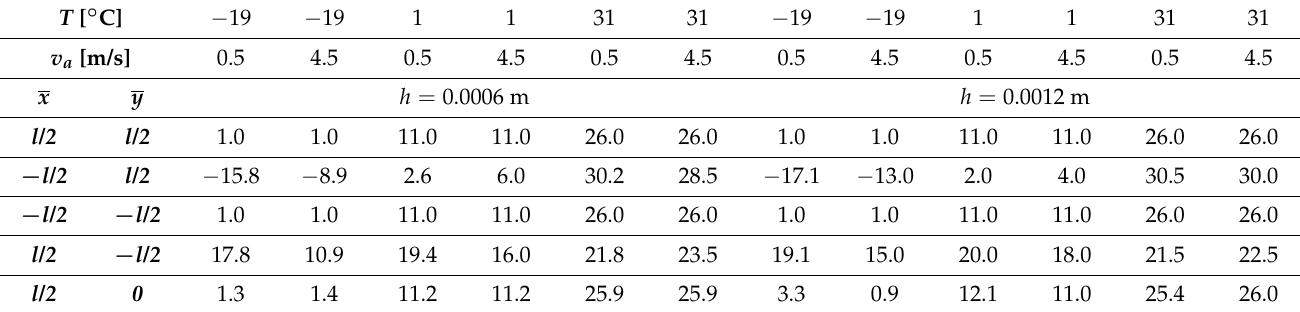
It is worth noting how the cross-flow heat exchanger behaves when the plate is twice as thin as the one adopted for this article. An aluminium plate was used for the tests. The presented research shows that the thinner the plate, the less the supply air heats up, although the differences are small. The differences in the final air temperatures are a bit closer to 21 ◦ C (room temperature) at the point ( − l /2, l /2, 0 ) when T c = − 19 ◦ C and T c = 1 ◦ C, as shown in Table 13. At the points ( l /2, l /2, 0 ) and ( − l /2, − l /2, 0 ) , the values of the temperature are equal for both assumed values of plate thickness. At ( l /2, − l /2, 0 ) (inlet of the exhaust air from the room), the temperature values are closer to 21 ◦ C (room temperature) for h = 0.0012 m. Similar results were obtained for a steel plate (Table 14). Table 13. Comparison of the temperatures in the corners of a plate and at the midpoint of the plate’s surface facing the heated air inlet to the room made of 0.0012 m and 0.0006 thick aluminium plates, for an air exchange duration of t end = 300 s, and air velocities of v a = 0.5 m/s and v a = 4.5 m/s.